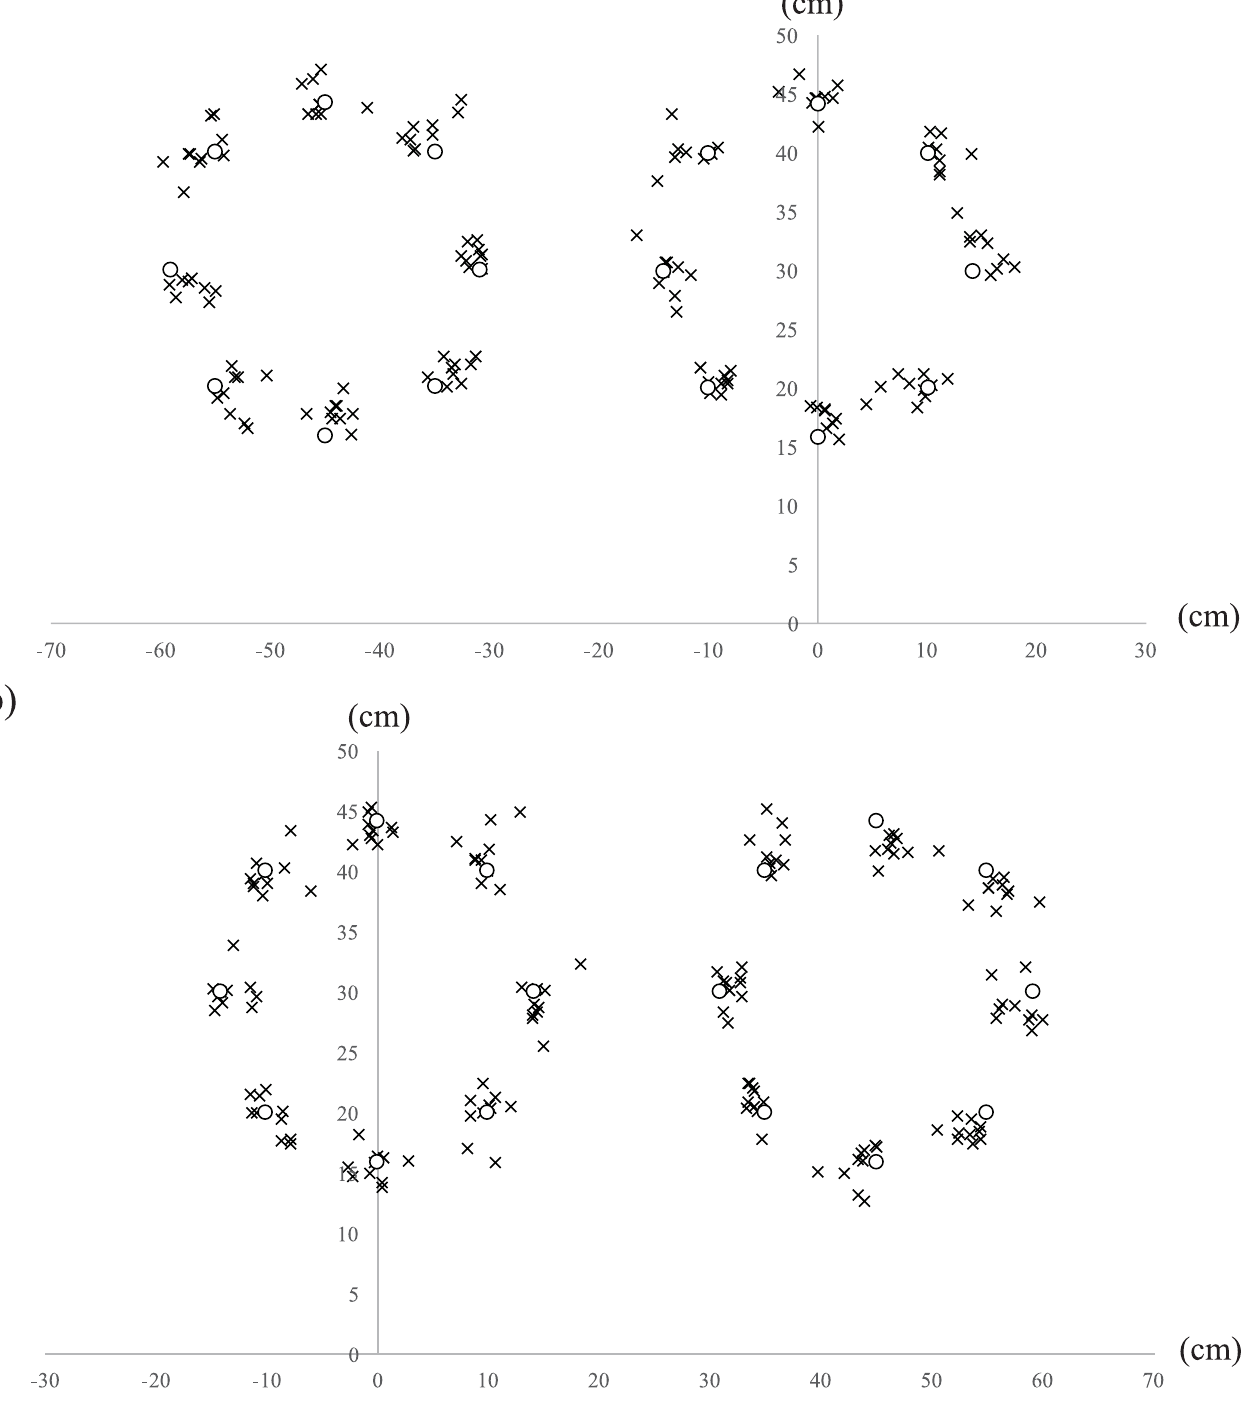
Fig 3. Scatter diagram of the mean positions of the reproduced magnet for each layout for each participant (crosses). White circles show the accurate positions of the magnets. 0 shows the position of the participant. a) Left hand group ( N = 9) and b) Right hand group ( N = 10).